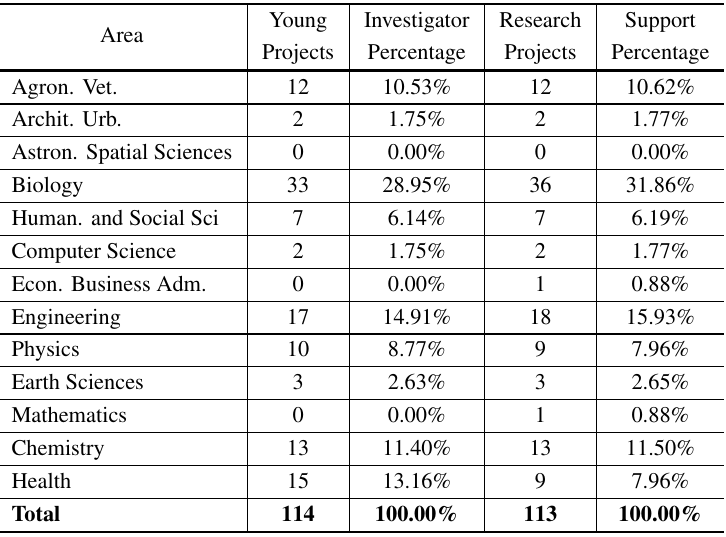
Projects selected for